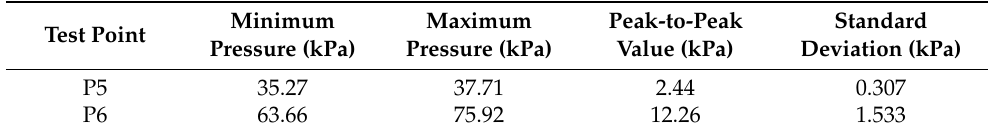
Table 1. Pc = 4.34 MPa. Data statistical analysis results.